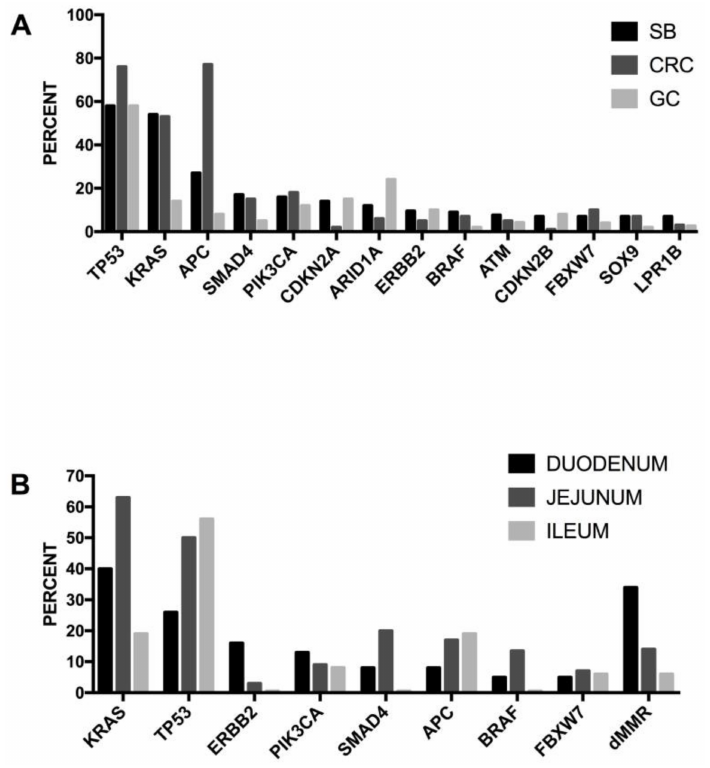
Figure 11. Recurrent genetic abnormalities observed in small bowel adenocarcinoma. ( A ): Frequency of genomic alterations in small bowel adenocarcinoma (SB), colorectal cancer (CRC) and gastric cancer (GC). ( B ): Frequency of genomic alterations in SB adenocarcinomas, subdivided according to tumor location. These data are reported in Schrock et al.